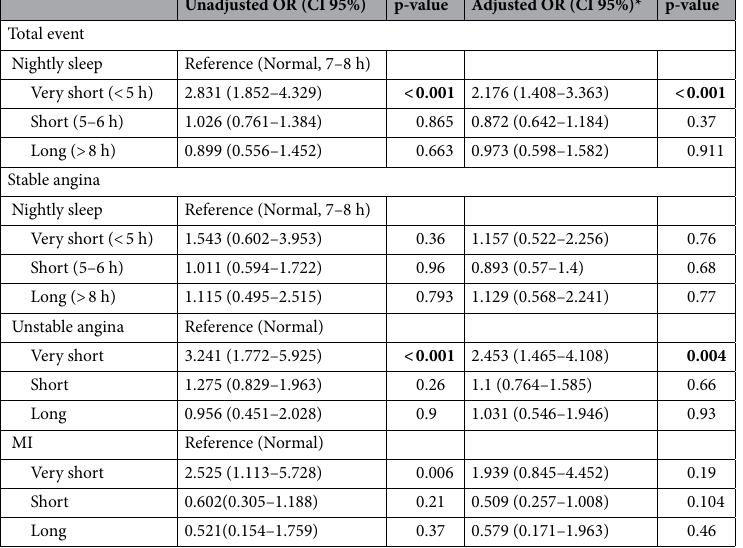
Table 2. Multinomial logistic regression of nightly sleep according to the event status. *Adjusted by sex, age, smoking, BMI, SBP and DBP. Significant values are in bold.